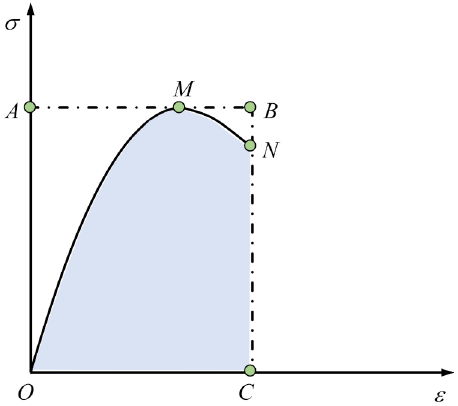
Figure 12. Diagram for calculation of energy-dissipation